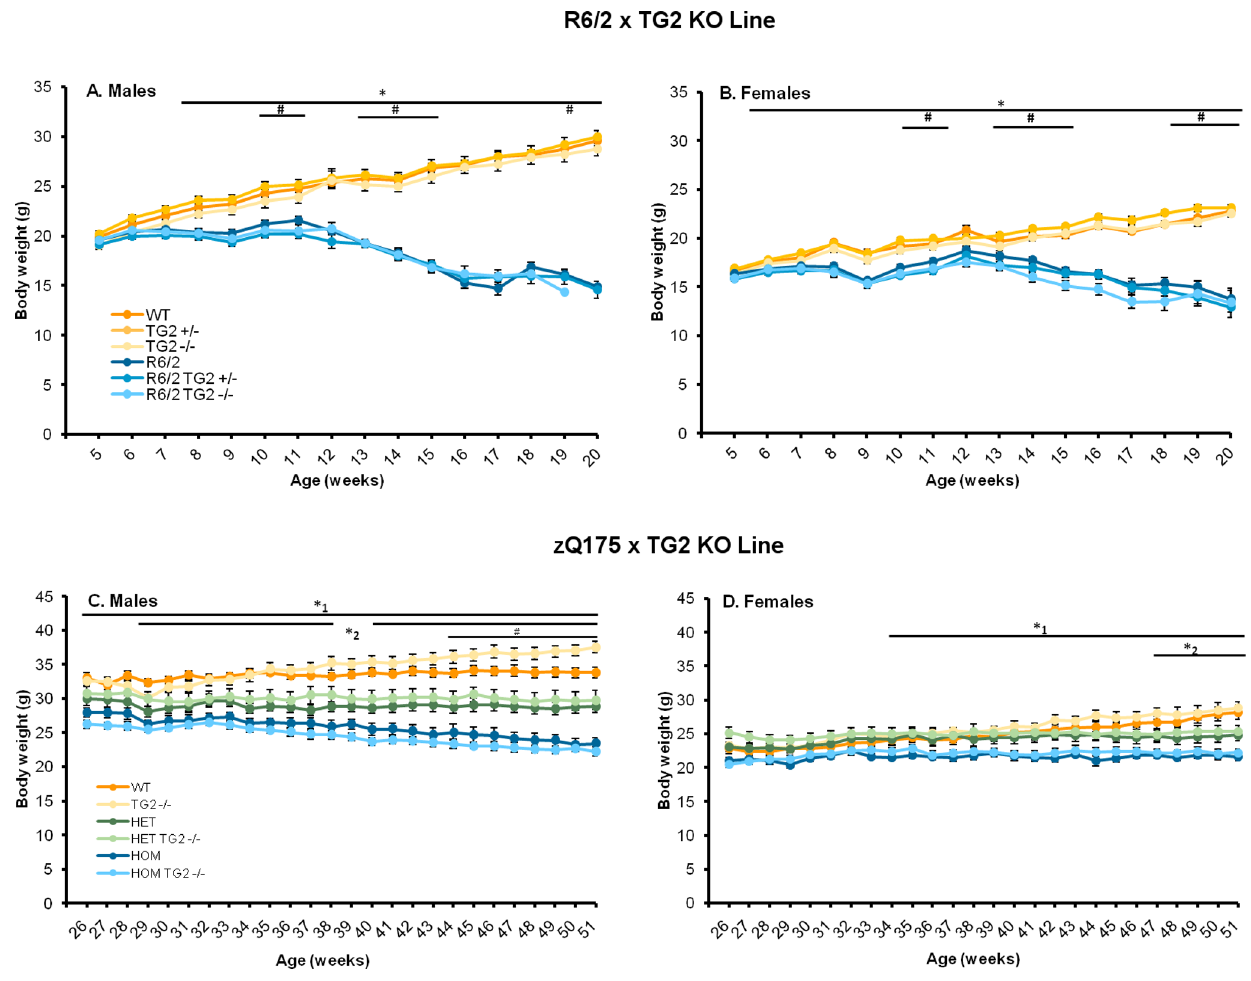
Figure 2. Body weight curves. A–B. Mean body weights of mice from the R6/2 6 TG2 KO line. A. Male mice (n=14–16 per genotype). B. Female mice (n=13–16 per genotype). C–D Mean body weights of mice from the zQ175 6 TG2 KO line. A. Male mice (n=5–6 per genotype). B. Female mice (n=6–7 per genotype). *Significant differences R6/2 vs WT,* 1 significant differences HOM vs WT, * 2 significant differences HET vs. WT, # significant TG2 genotype differences. WT: wild-type, TG2 + / 2 : heterozygous TG2 knockout, TG2 2 / 2 : homozygous TG2 knockout, HET: zQ175 HET HOM: zQ175